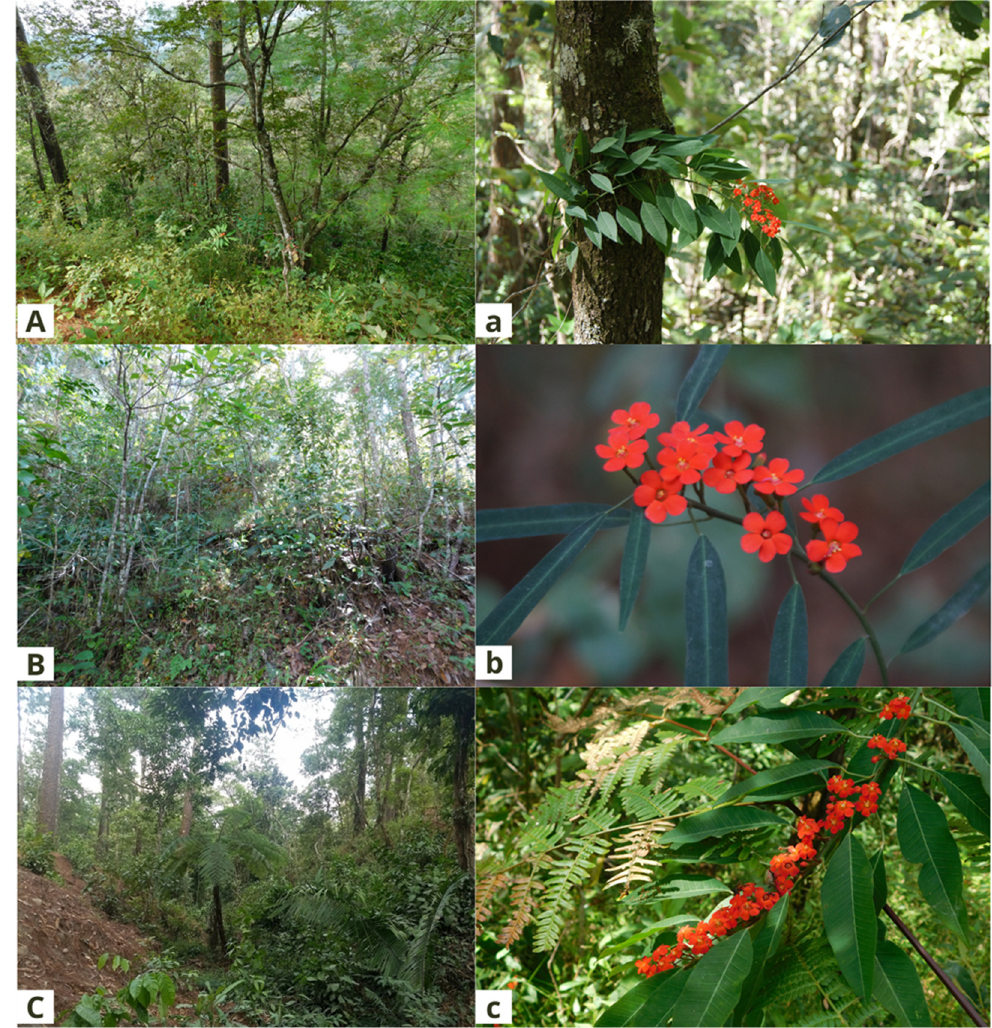
Figure 1. Wild populations of Euphorbia fulgens in the state of Oaxaca. Population 1, ( A , a ). San Jerónimo Coatlán; population 2 ( B , b ). Santiago Jamiltepec; population 3 ( C , c ). Santa Catarina Juquila. The capital letters show the species’ habitat, and the lowercase letters show its inflorescences.